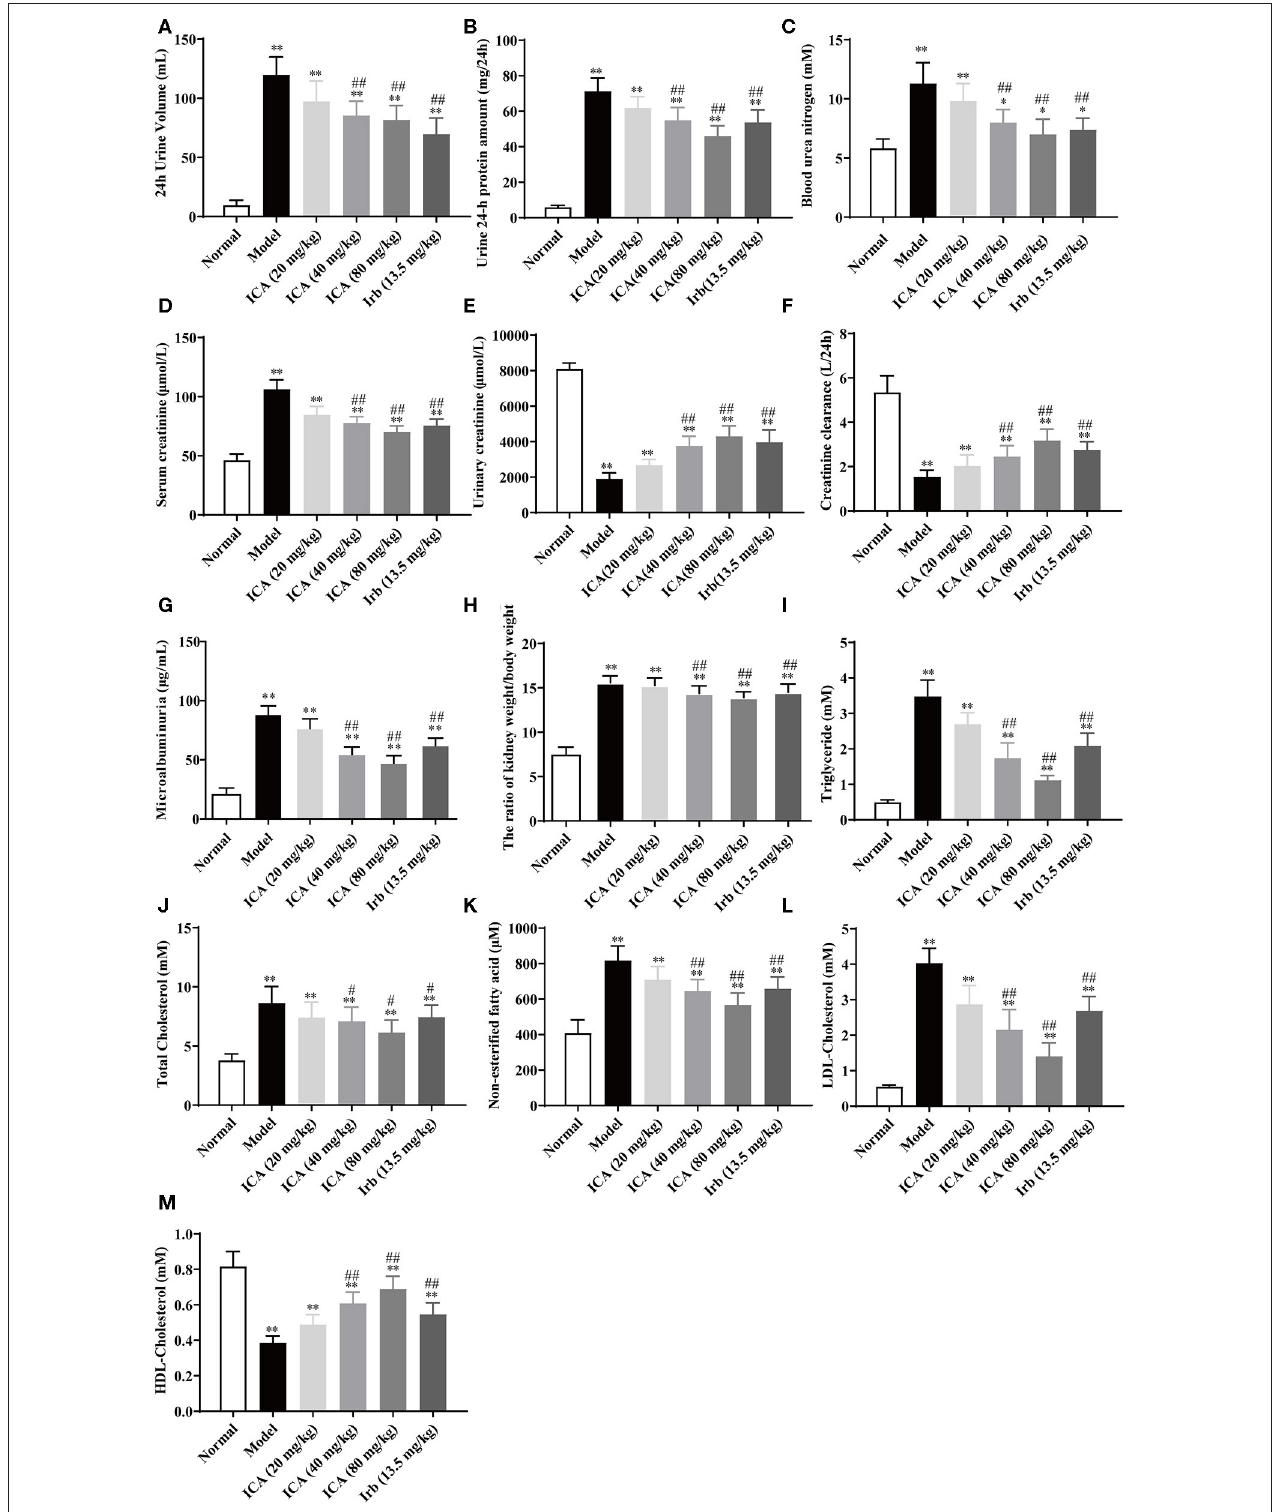
FIGURE 4 | Effects of icariin on metabolic parameters in kidney damage rats. (A) The 24h urinary volume, (B) 24h proteinuria, (C) Blood urea nitrogen (BUN), (D) Serum creatinine (Src), (E) Urinary creatinine, (F) Creatinine clearance, and (G) 24h urinary albumin excretion were measured by ELISA. (H) The ratio of kidney weight to body weight. (I) Triglyceride, (J) Total Cholesterol, (K) Non-esterified fatty acid, (L) LDL-Cholesterol and (M) HDL-Cholesterol were measured by ELISA. Data are expressed as mean ± SD ( n = 10). * p < 0.05, ** p < 0.01, compared with the normal control group; # p < 0.05, ## p < 0.01, compared with the Model group.